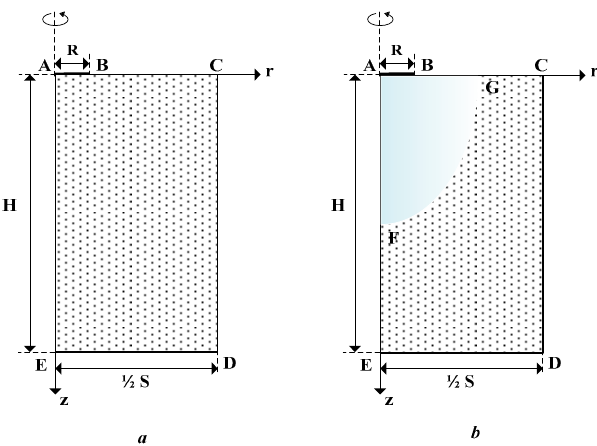
Figure 2. Simplified graph of film hole irrigation model (( a ) represents the three-dimensional axisymmetric domain; ( b ) represents the wetting pattern during the infiltration process).